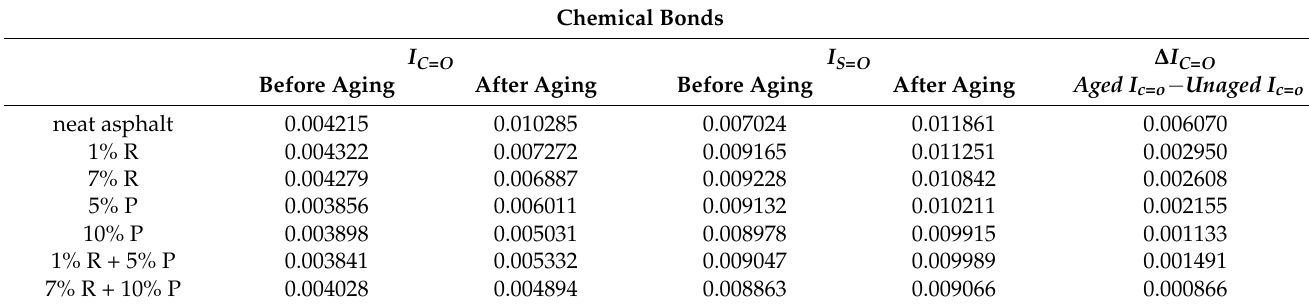
Table 5. Group indices of various modified asphalt binders before and after aging took place. Chemical